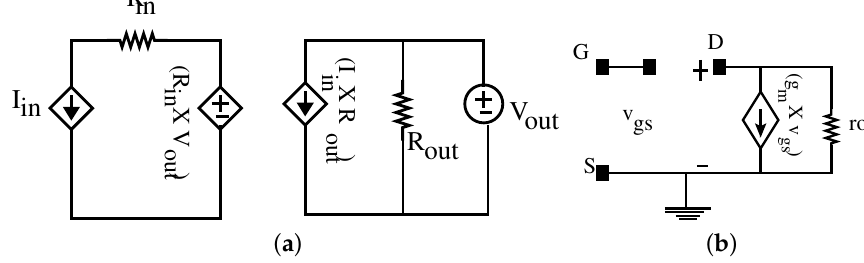
Figure 4. ( a ) Two port equivalent network of the proposed circuit. ( b ) Small signal equivalent model of transistor based